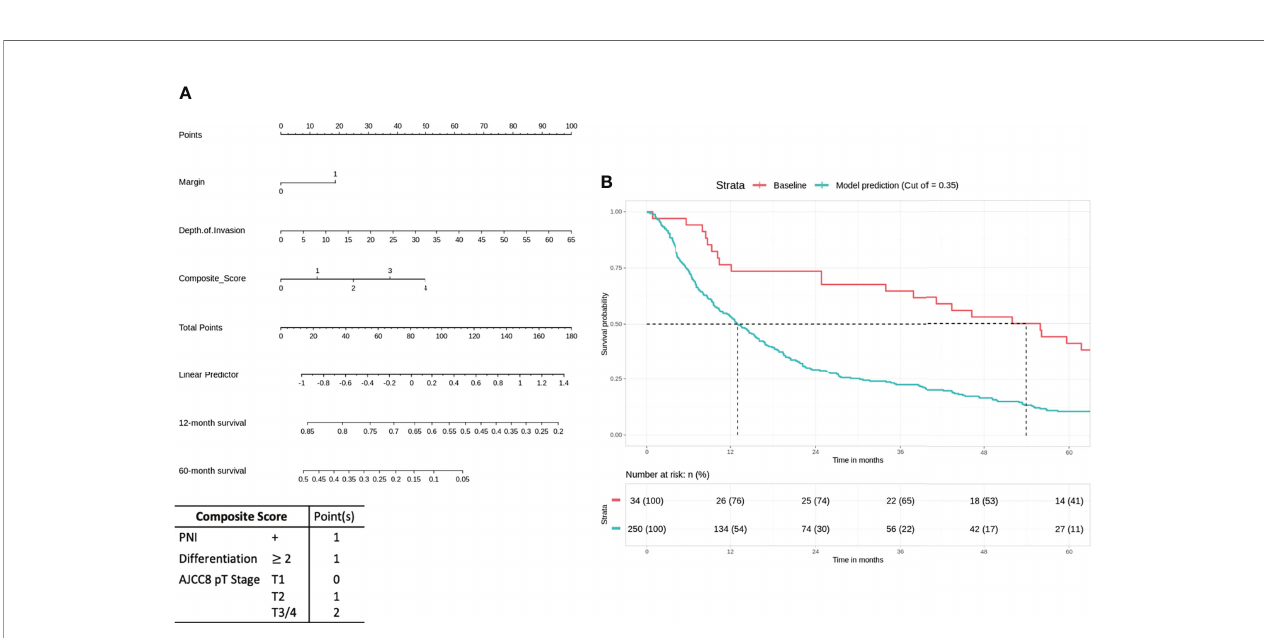
FIGURE 3 | Intermediate-risk group: bone invasion is a signi fi cant negative prognosticator for overall survival (OS). (A) Nomogram model. (B) Internal validation: prediction of 5 ‐ year overall survival with nomogram model as compared to baseline (PR AUC = 0.836). PR AUC, precision – recall area under the curve.